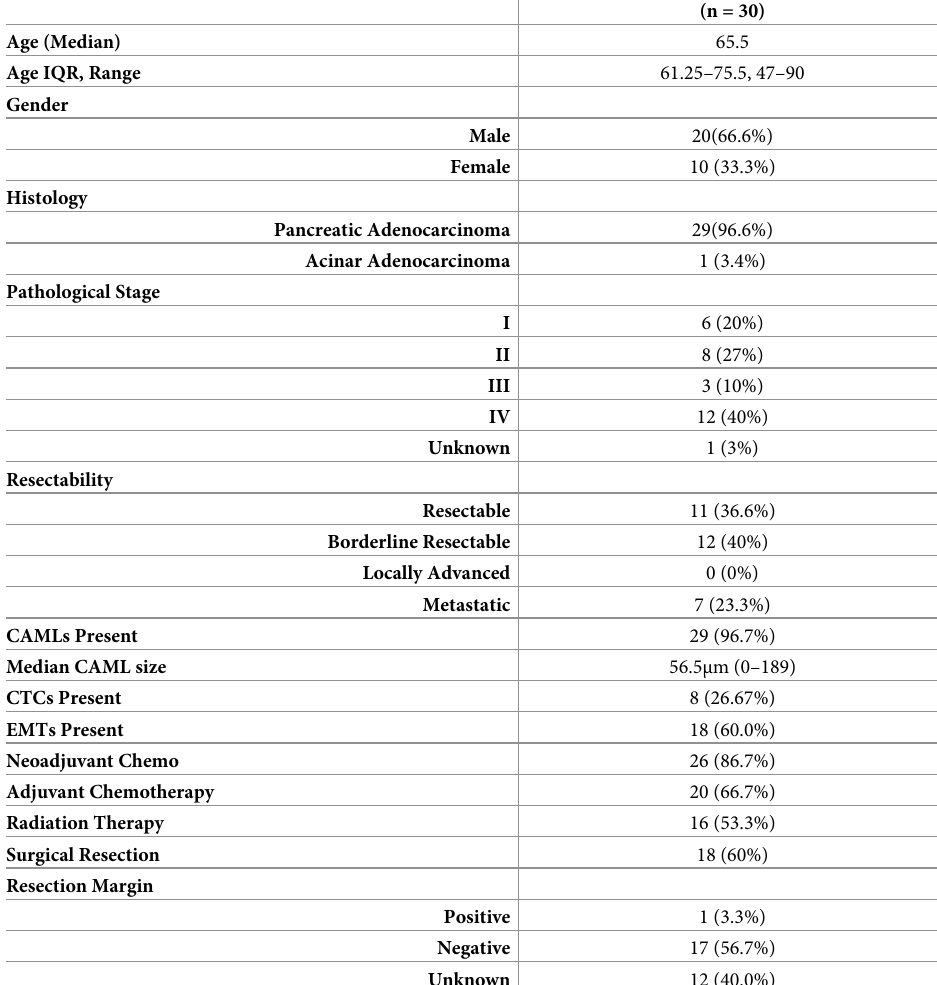
Table 1. Clinical demographic information for